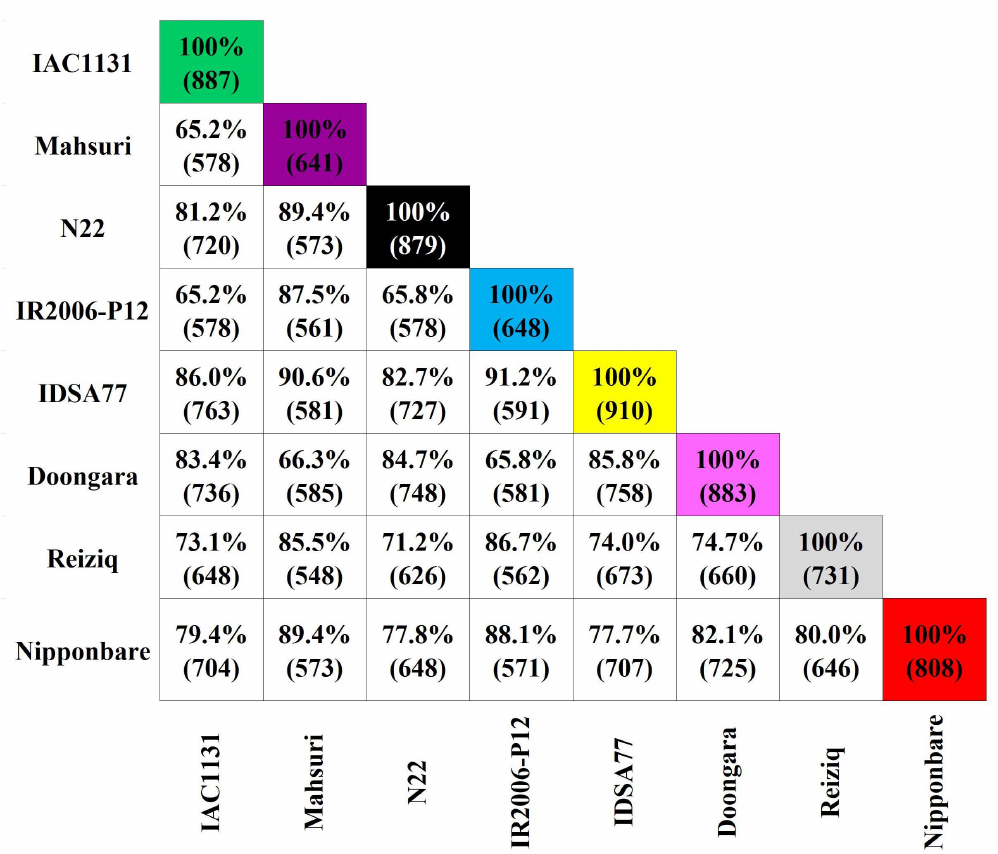
Figure 1. Number of proteins identified in genotypes of rice under control and stress conditions. The white squares show the pairwise overlap of the proteins identified in each genotype of rice. The diagonals show the total number of proteins identified in each